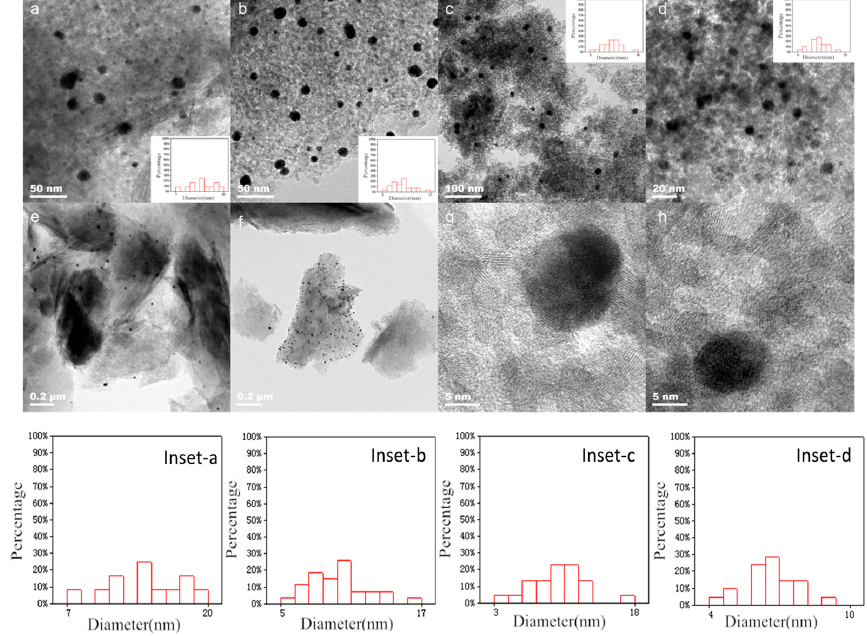
Figure 3. Transmission electron microscopic (TEM) images of the samples. ( a , e ) Au/Na-ABen; ( b , f ) Au/Ti-Na-ABen; ( c , g ) Au-Ti/Na-ABen; ( d , h ) Au-Ti-Ce/Na-ABen.